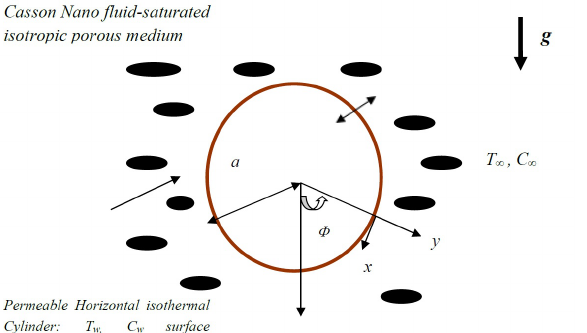
Fig. 1: Physical Model and Coordinate